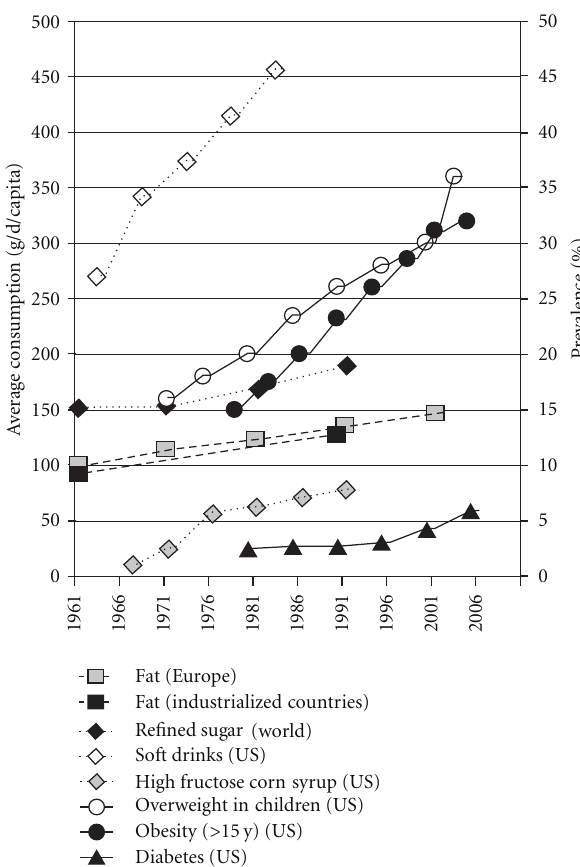
Figure 1: Evolution of Occidental dietary content in specific macronutrients and prevalence of obesity and diabetes in United States. Compiled from [11–13]; FAO, AGROSTAT.PC, 1993; Centers for Disease Control and Prevention, National Center for Health Statistics, Division of Health Interview Statistics, data from the National Health Interview Survey; French National Epidemiological Study on Overweight and Obesity: ObEpi-Roche 2009.